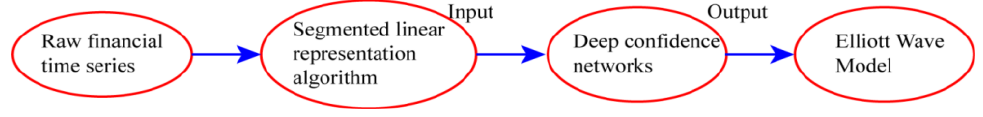
Figure 3. The basic framework of the DL-EWP model.